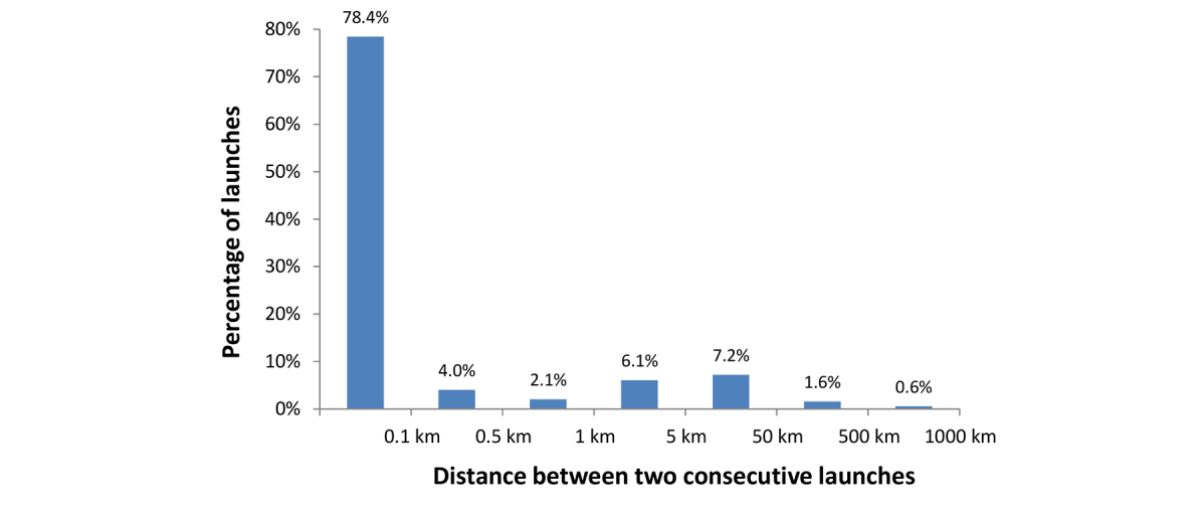
Figure 8. Percentage of app launches vs the distance to the location of the previous launch. Most consecutive app launches occurred at the same place. Excluding the bin for the same location, there is a sizeable peak between 5 km and 50 km, which indicates that 7.2% of the consecutive app launches were separated by a distance of 5-50